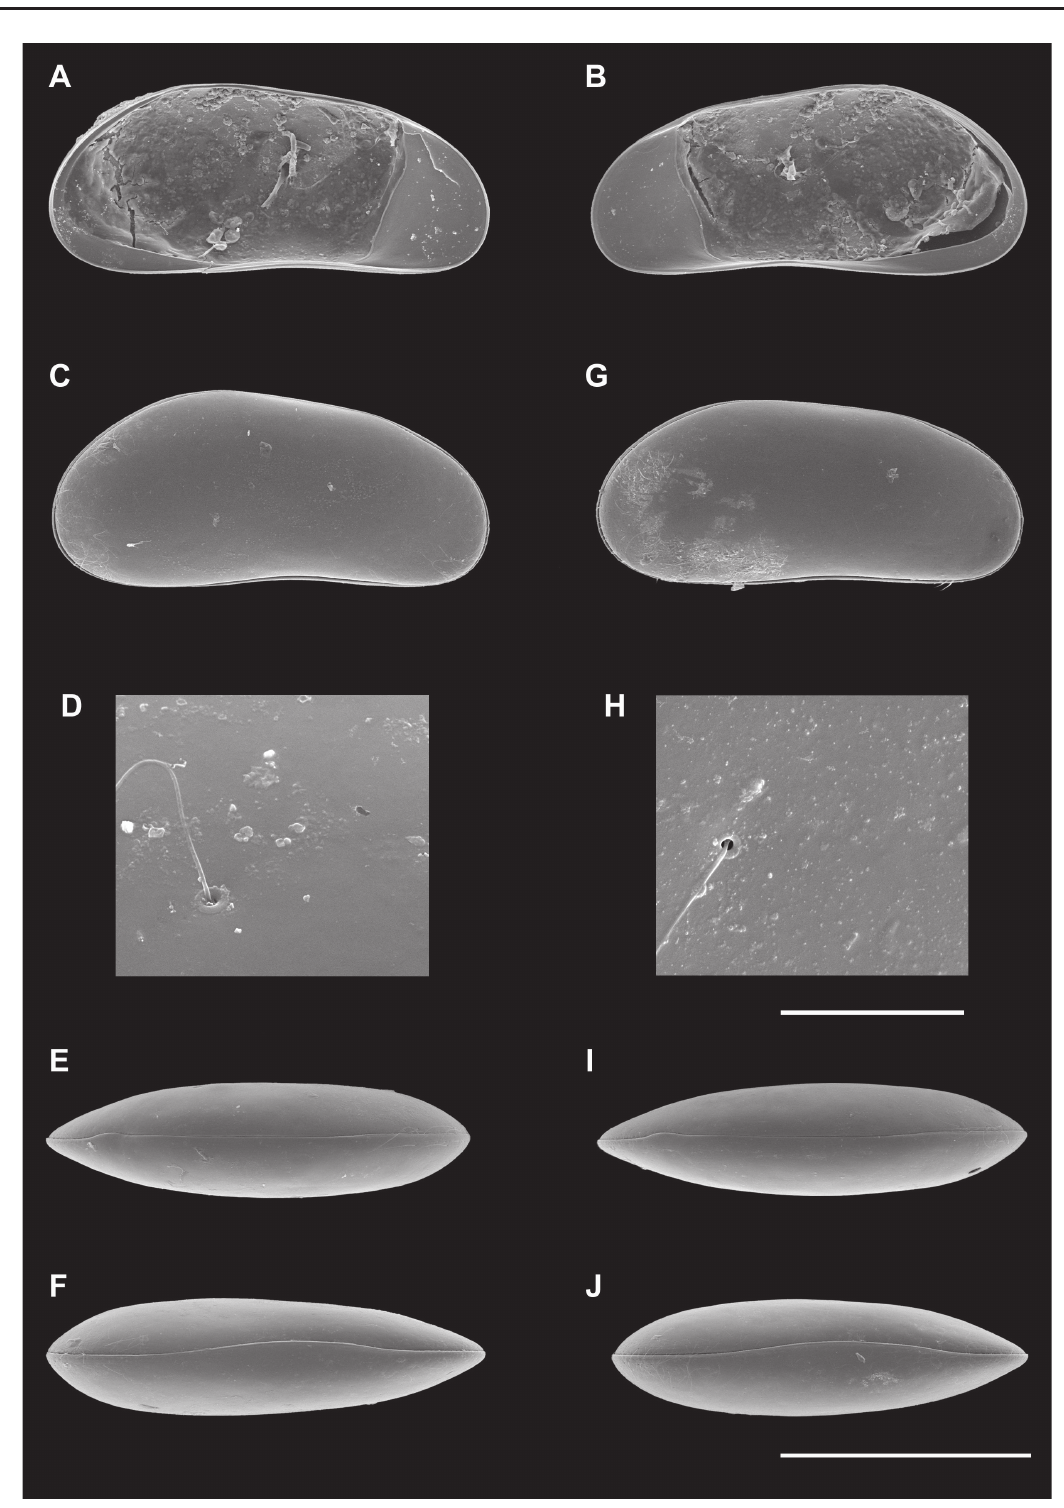
Fig. 12. Valves of Candobrasilopsis acutis sp. nov. C–F ♂ and A–B, G–J ♀. A . LV, internal view. (MZUSP 32701) B . RV, internal view (MZUSP 32701). C, G . Cp, right lateral view (C = MZUSP 32700, G = MZUSP 32706). D, H . Cp, right lateral view, detail (D = MZUSP 32700, H = MZUSP 32706). E, I . Cp, dorsal view (E = MZUSP 32704, I = MZUSP 32707). F, J . Cp, ventral view (F = OC. 3358, J = OC. 3360). Scale bars: A–C, E–G, I–J = 500 µ m; D, H = 20